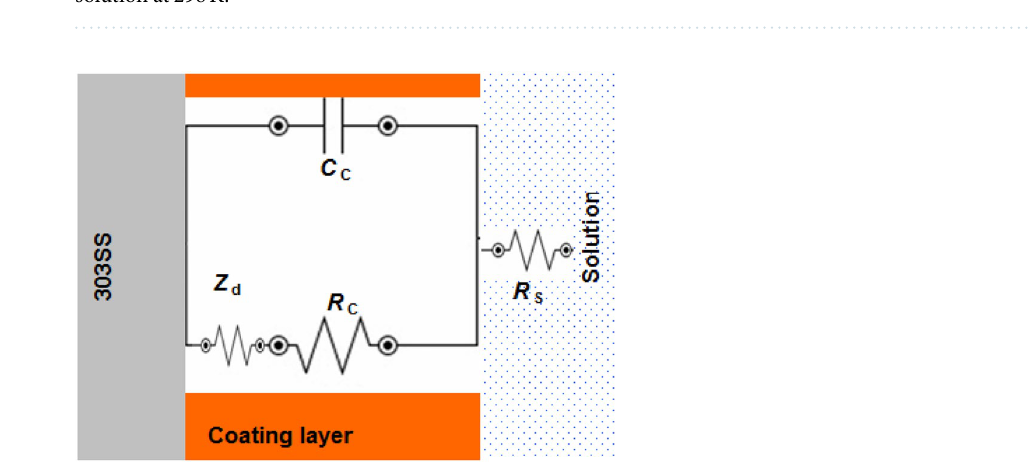
Figure 5. Nyquist plots for coated 303 SS by the neat PANI and PANI/Zn-Pr composites in 1.0 M H 2 SO 4 solution at 298 K.